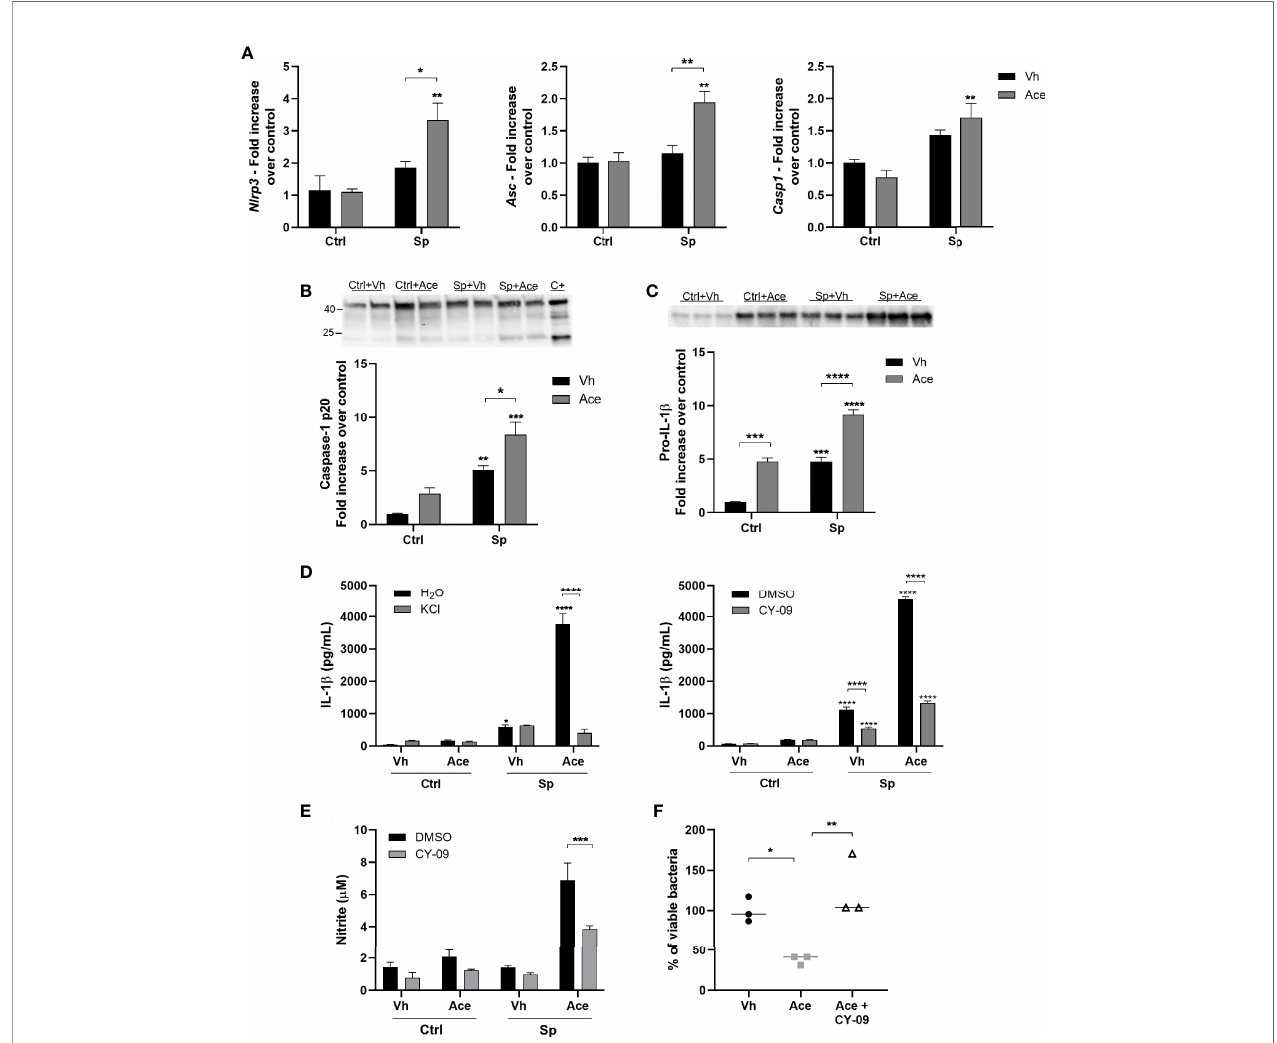
FIGURE 4 | Acetate increases the secretion of IL-1 b via NLRP3. (A) Fold increase of Nlrp3 , Asc and Casp1 mRNAs assessed by RT-PCR from MPI cells pre- treated or not with acetate and stimulated or not with S. pneumoniae for 18 h. Fold increase was calculated over control (Ctrl+Vh). (B , C) Western blot for Caspase 1 from supernatant and pro-IL-1 b from cellular lysate of MPI cells pre-treated or not with acetate, and then incubated or not with S. pneumoniae for 24 h. Caspase-1 p20 and pro-IL-1 b quanti fi cations were normalized to total lane density (total protein) from stain free gel image. For caspase 1, a positive control was done adding 300 ng/mL of LPS for 4 h, followed by 20 µM of nigericin for 30 min. Western blot for caspase 1 was done in duplicates/triplicate and repeated three times. Graphic shows a pool from the mean of three independent experiments. (D) ELISA for IL-1 b from supernatants of MPI cells pre-treated or not with acetate, KCl or CY-09 and then stimulated or not with S. pneumoniae for 24 h. (E) Nitrite concentration assessed by Griess assay from supernatant of MPI cells pre-treated or not with acetate in the presence of absence of CY-09 30 µM and stimulated or not with S. pneumoniae during 48 h. (F) % of intracellular viable bacteria left 6 h post infection of activated MPI cells treated or not with acetate and/or CY-09 30 µM, normalized to vehicle group. Bars showing the mean and error showing the SEM (A – E) and data showing the median (F) of triplicates. Results are representative of three independent experiments. Statistical analysis was done using Two-way ANOVA (A – E) and One-Way ANOVA (F) corrected with Sidak ’ s multiple comparisons test (*p < 0.05, **p < 0.01, ***p < 0.001, ****p <